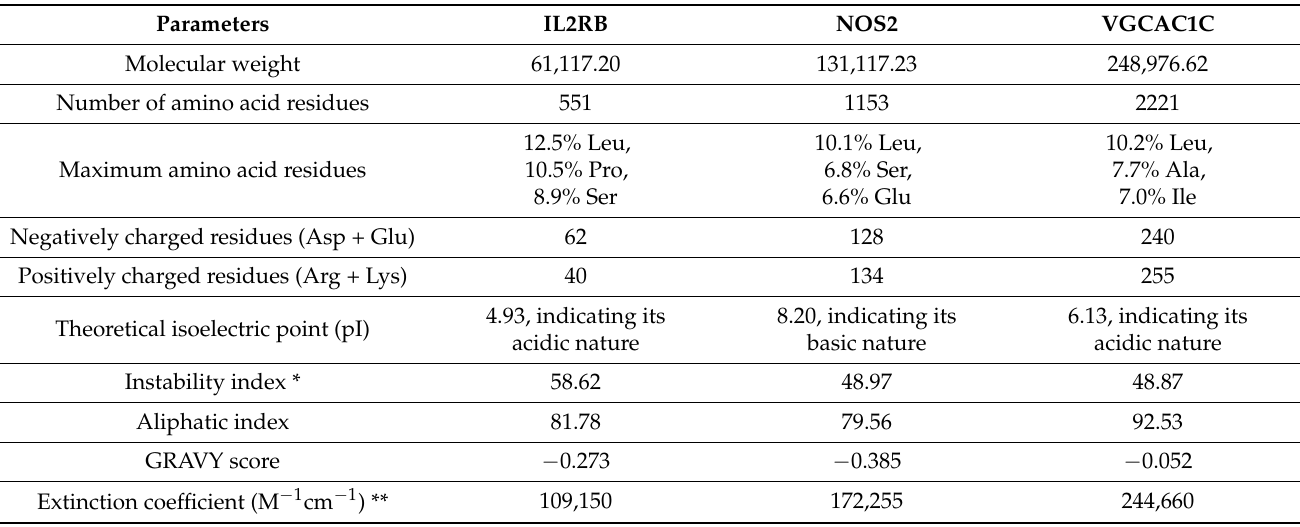
Table 3. Physiochemical properties of